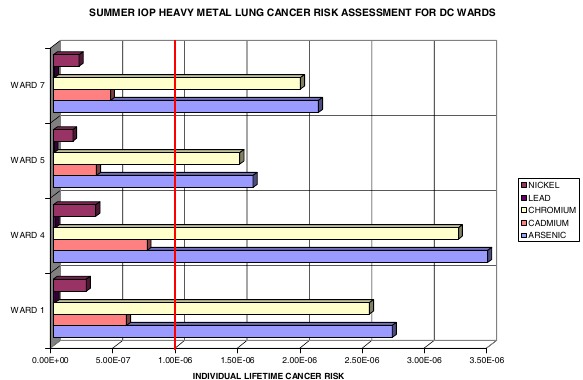
Figure 10: Summer IOP Lifetime Excess Lung Cancer Risk by DC Wards.